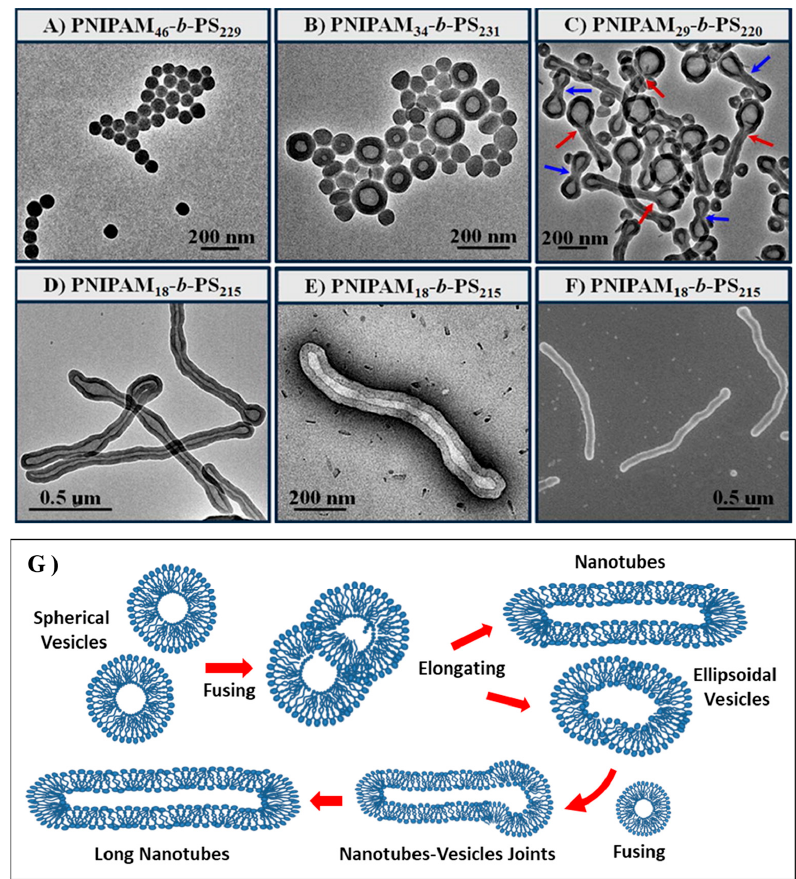
Figure 10. TEM ( A–E ) and scanning electron microscopy (SEM) ( F ) images of the